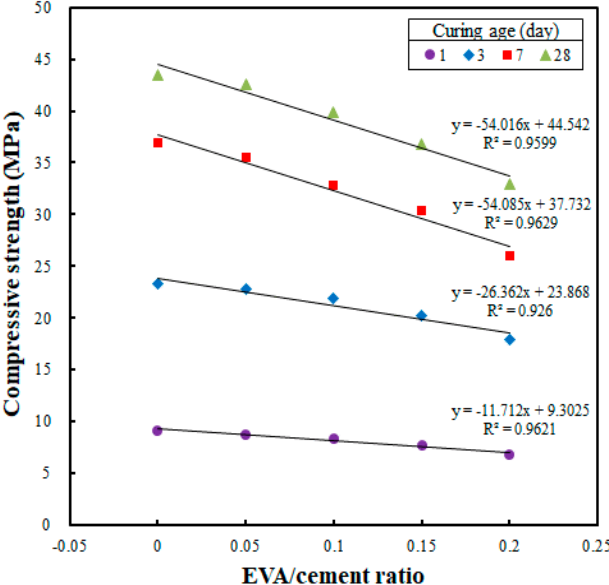
Figure 3. Relationship between EVA / cement ratio and compressive strength for cast specimens at different curing ages.